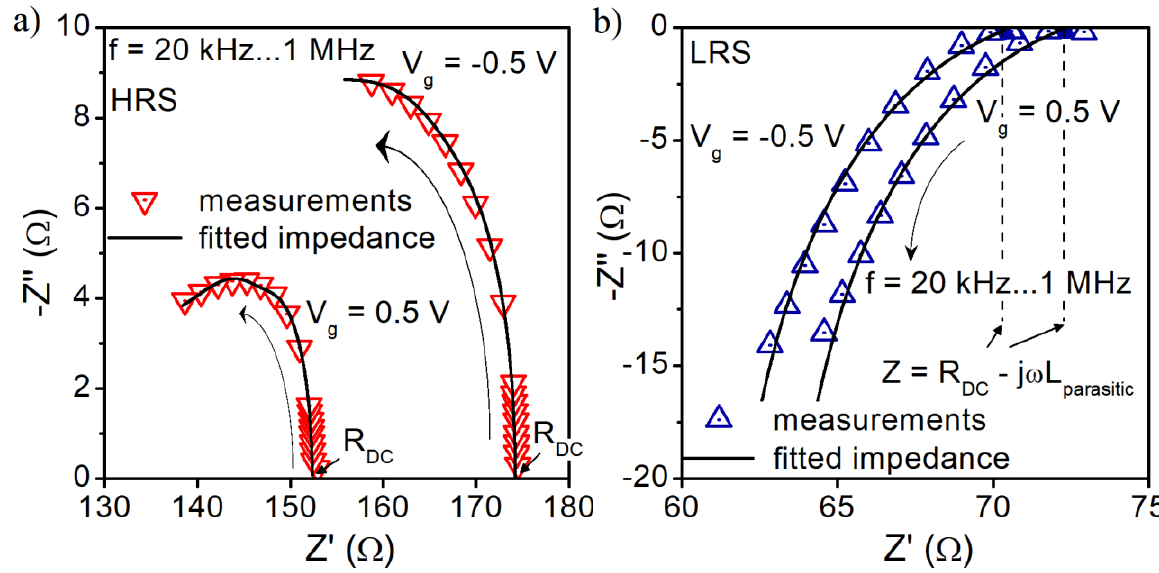
Figure 8. Complex impedance spectra of investigated structure (S1) for a frequency range of 20 kHz–1 MHz at different gate bias voltage values in ( a ) HRS and ( b ) LRS.